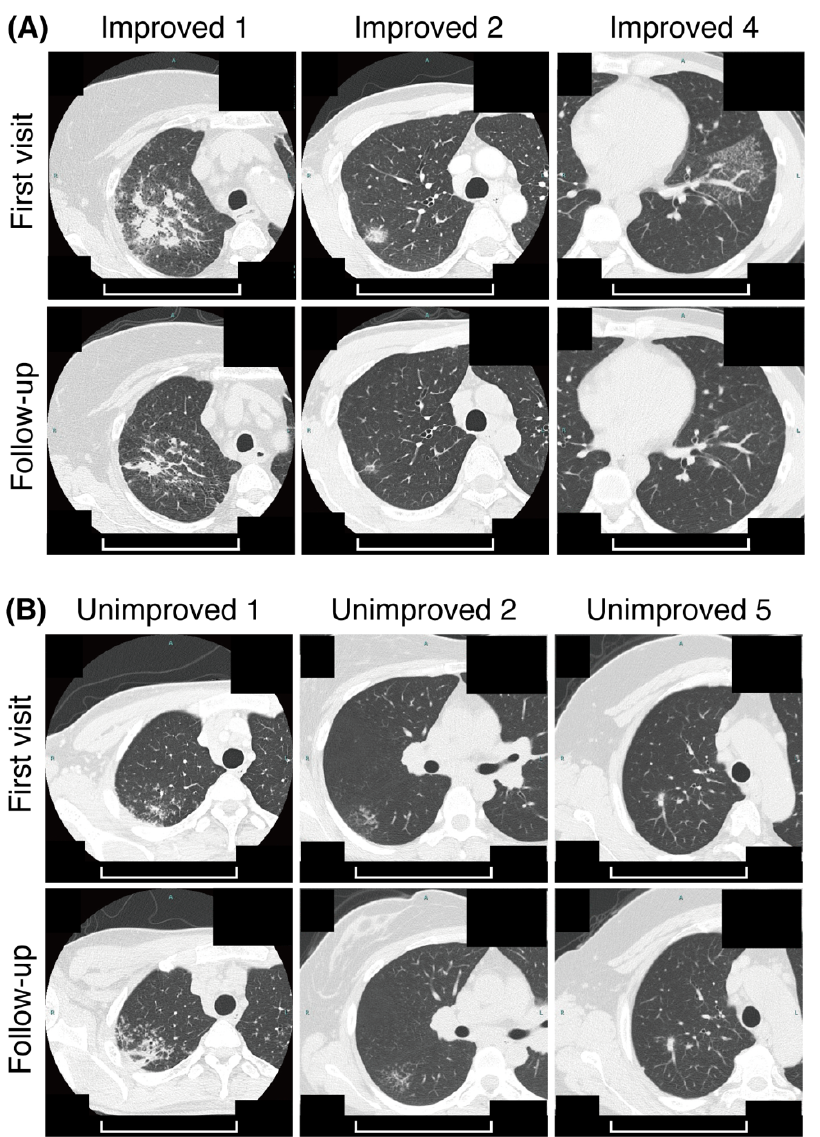
Figure 1. Computed tomography (CT) imaging changes in patients with sarcoidosis. CT images of